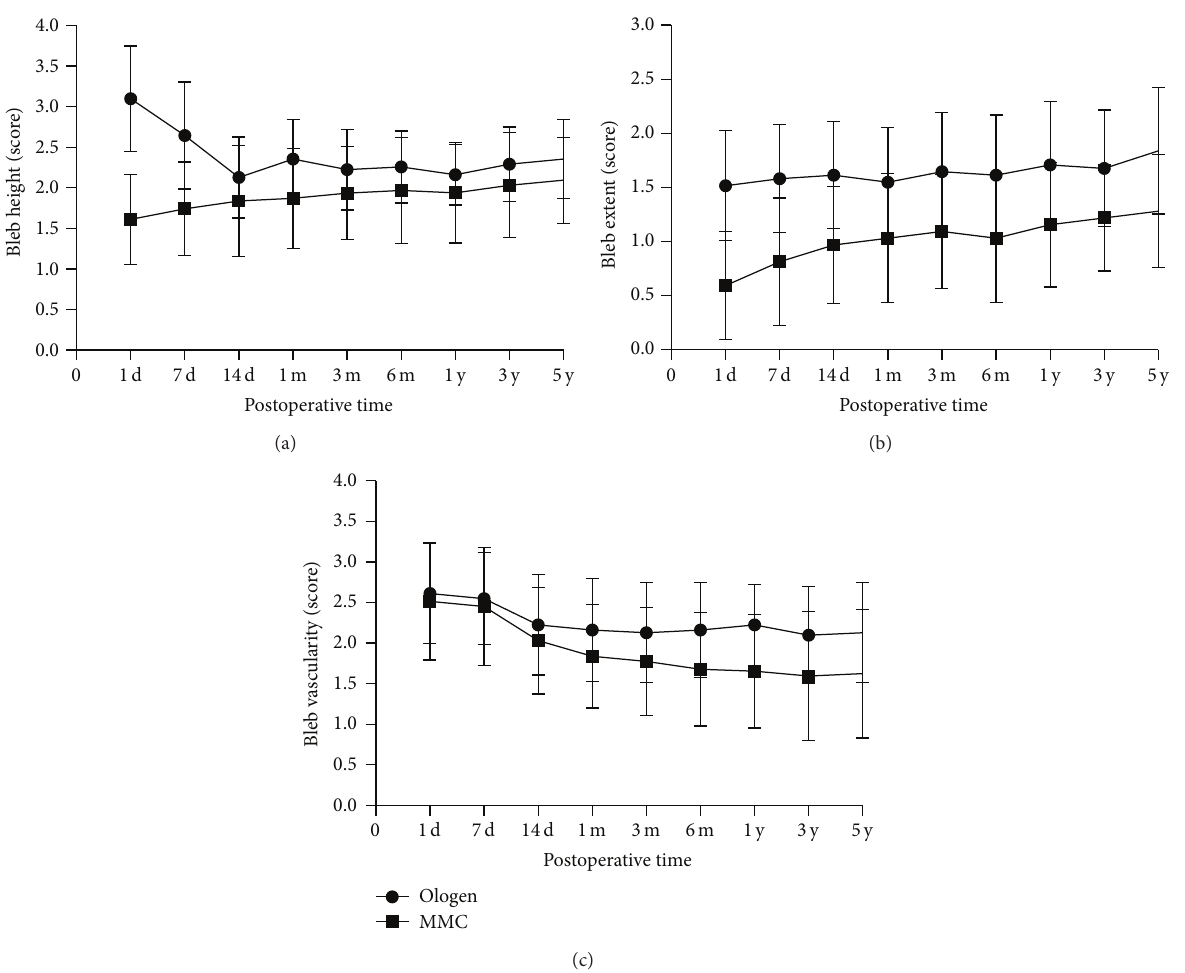
Figure 2: (a) The mean bleb extent during the postoperative course. The bleb extent was increased from 1 day after surgery to 5-year follow- up visit. The extent in Ologen group was larger than MMC group. (b) The mean bleb height during the postoperative course. In the early postoperative stage (up to 14 days), bleb height in Ologen group was higher than MMC group. From 14 days to 5-year visit, the bleb height was similar in both groups. (c) The mean bleb vascularity during the follow-up visit. In the early postoperative stage (up to 14 days), bleb vascularity in both groups was similar, the vascularity of MMC group was reduced from 1 month. At 5-year follow-up visit, the bleb vascularity in Ologen group was more than MMC